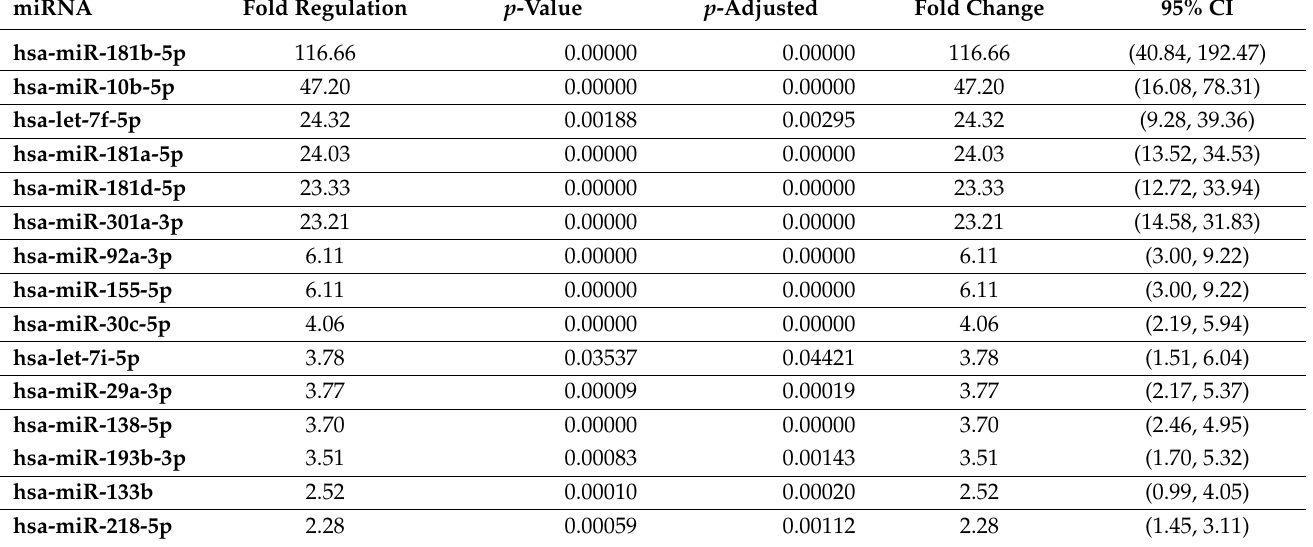
Table 1. Differentially expressed miRNAs of ± 2 fold regulation and p .adjust < 0.05 for non-responders vs. responders